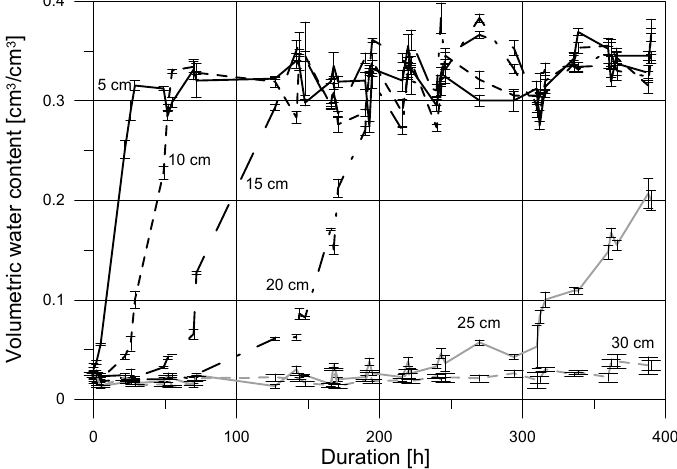
Figure 8. Capillary rise determined by TDR surface sensor in sample of aerated concrete.